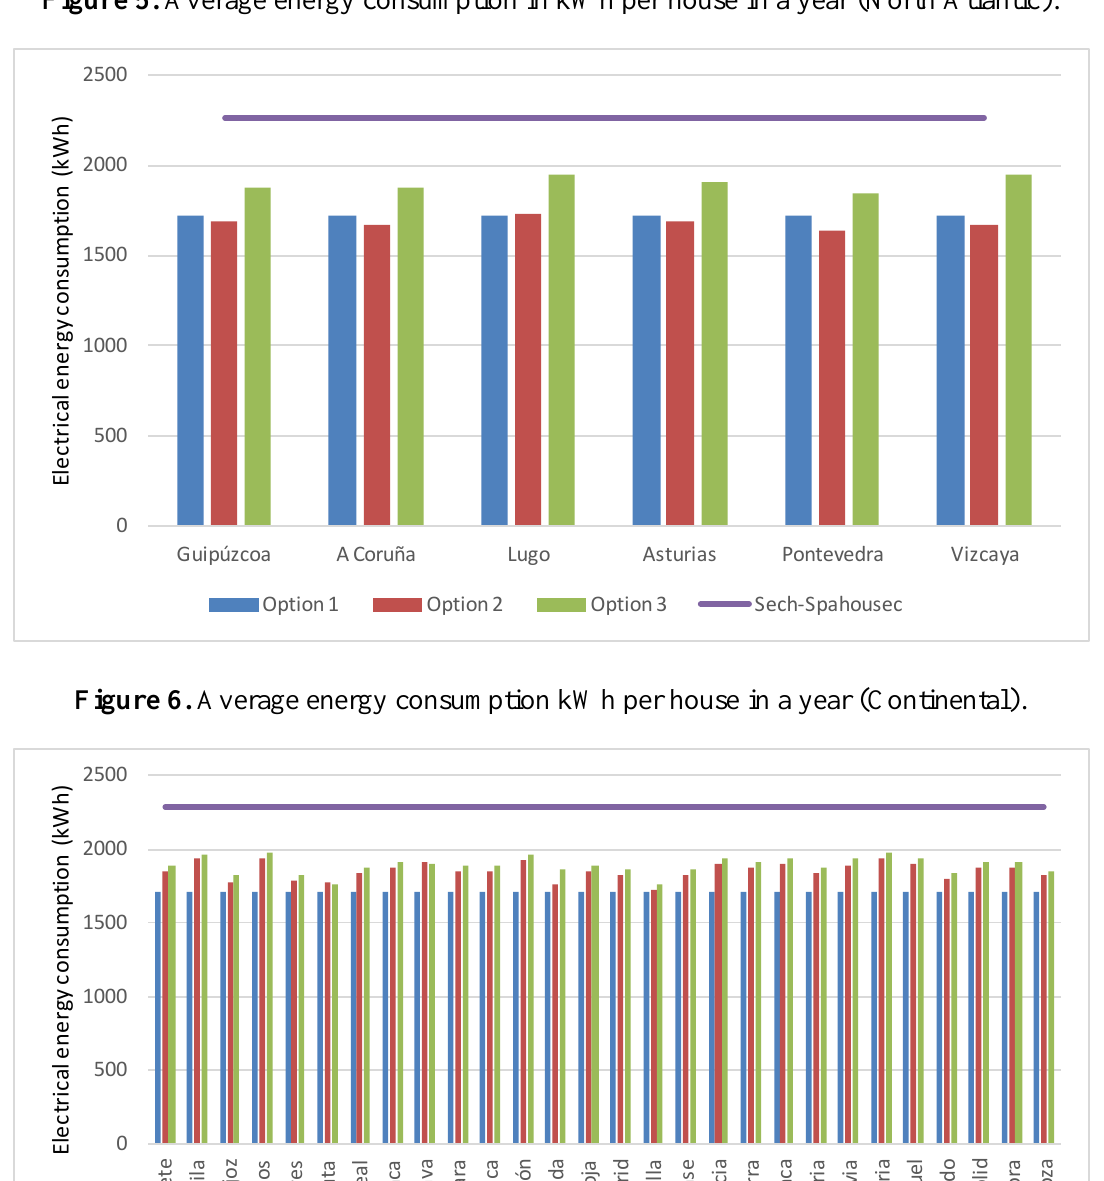
Figure 5. Average energy consumption in kWh per house in a year (North Atlantic).